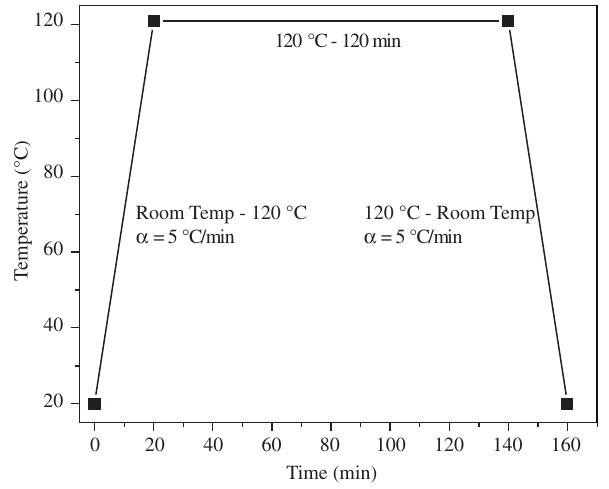
Figure 1. Heat treatment of the DGEBA/DDS and DGEBA/DDM samples.